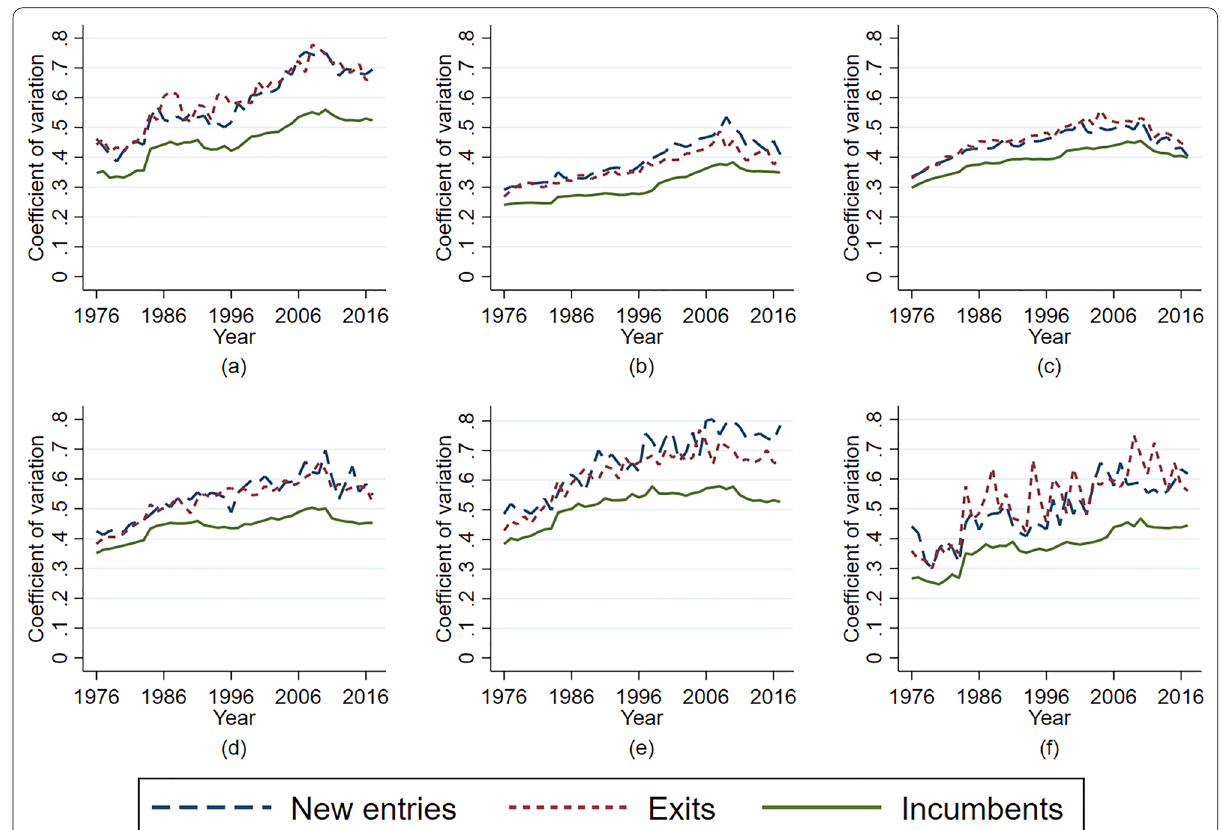
Fig. 16 Coefficient of variation for different types of establishments. a Contains only establishments belonging to the 25% of establishments with the highest share of high-skilled employees in the sample. b Contains only establishments belonging to the 25% of establishments with the highest share of employees performing easy manual tasks. c contains only establishments belonging to the 25% of establishments with the highest share of employees performing easy service tasks. d Contains only establishments belonging to the 25% of establishments with the highest share of employees performing easy commercial tasks. e Contains only establishments belonging to the 25% of establishments with the highest share of employees that are older than 50 years. f Contains only establishments with at least one engineer and/or natural